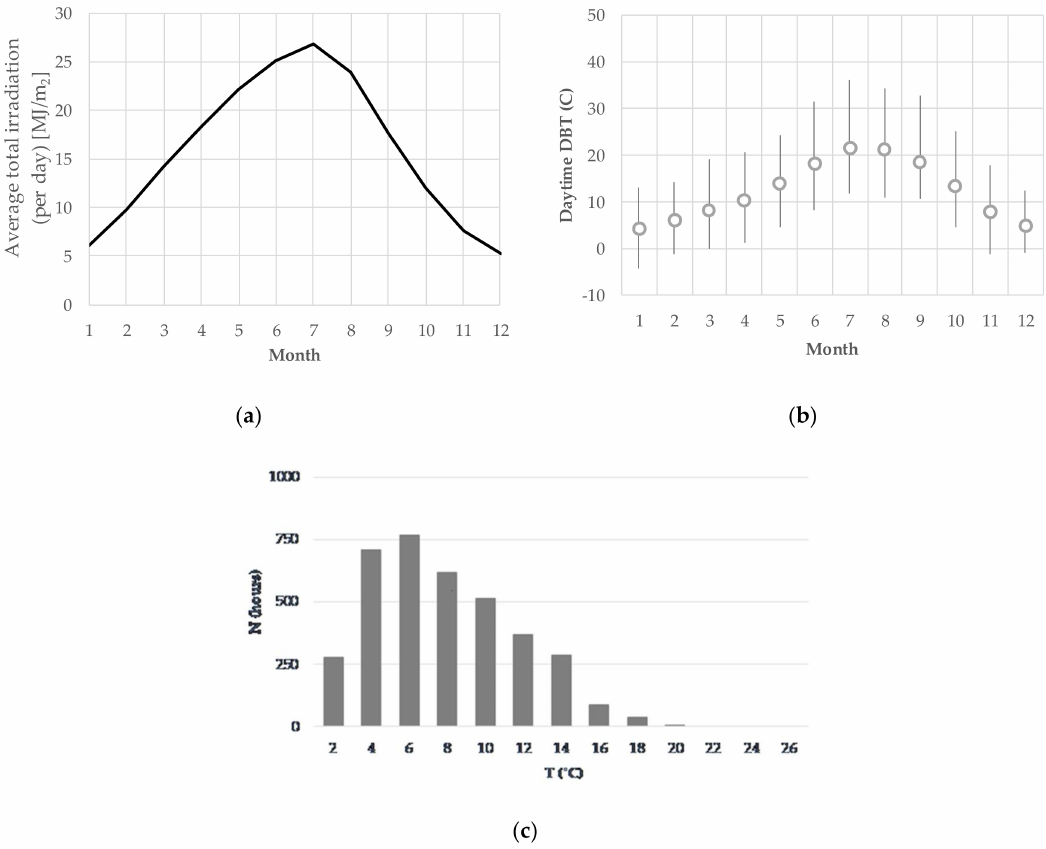
Figure 2. Climate data for Valladolid ( a ) average irradiation per day; ( b ) minimum, maximum and average dry bulb temperature for a typical day; ( c ) wet-bulb depression bin